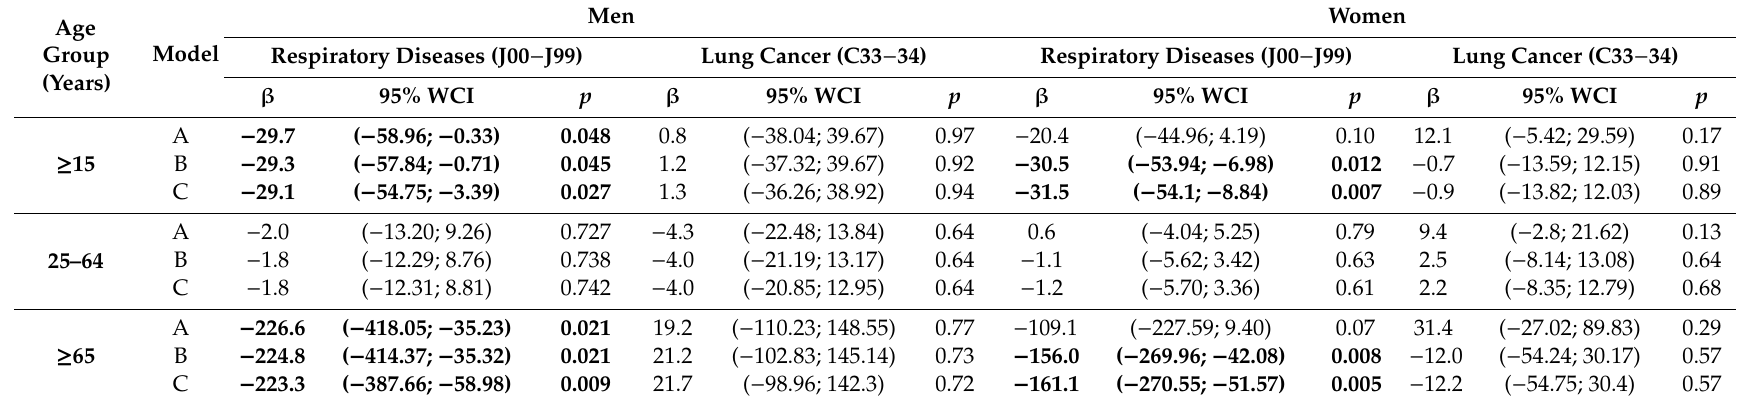
Table 3. Relationship between the change of socioeconomic status (SES) between 2010 and 2014 and mean SMR for respiratory diseases and lung cancer in 66 sub-regions of